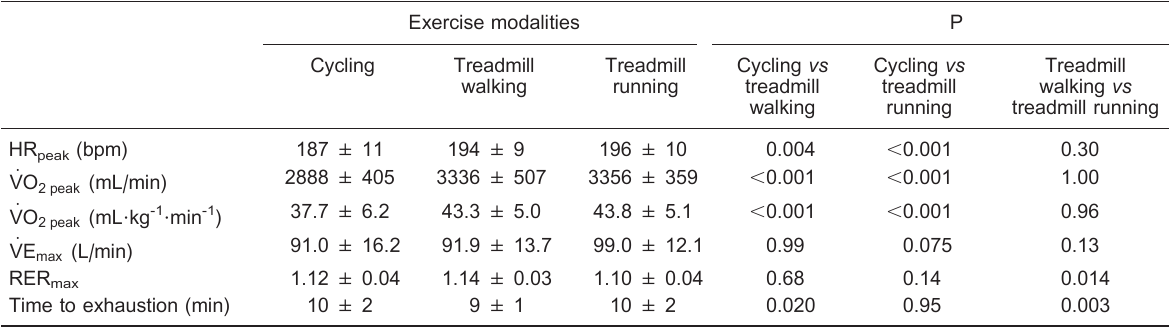
Table 1. Mean±SD values for HR peak , absolute maximal cardiopulmonary exercise tests.